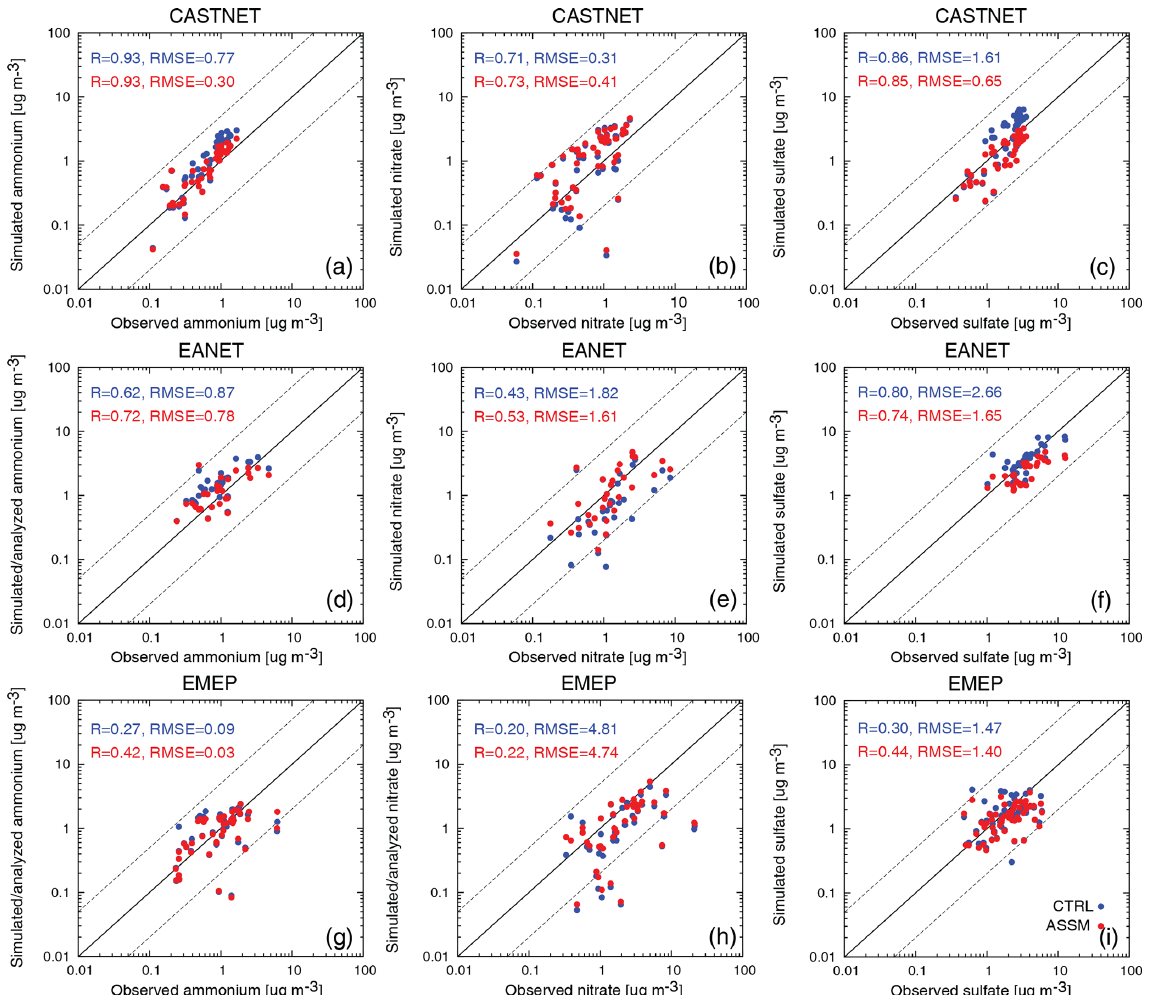
Figure 11. Comparisons of monthly mean surface aerosol concentrations between the control run (blue) and reanalysis (red) with the EMEP (a, b, c) , EANET (d, e, f) , and EMEP (g, h, i) observations for ammonium (a, d, g) , nitrate (b, e, h) , and sulfate (c, f, i) aerosols for